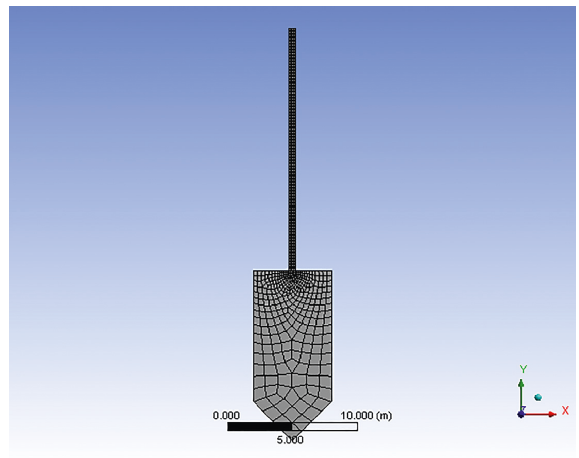
Figure 8: Mesh diagram of numerical